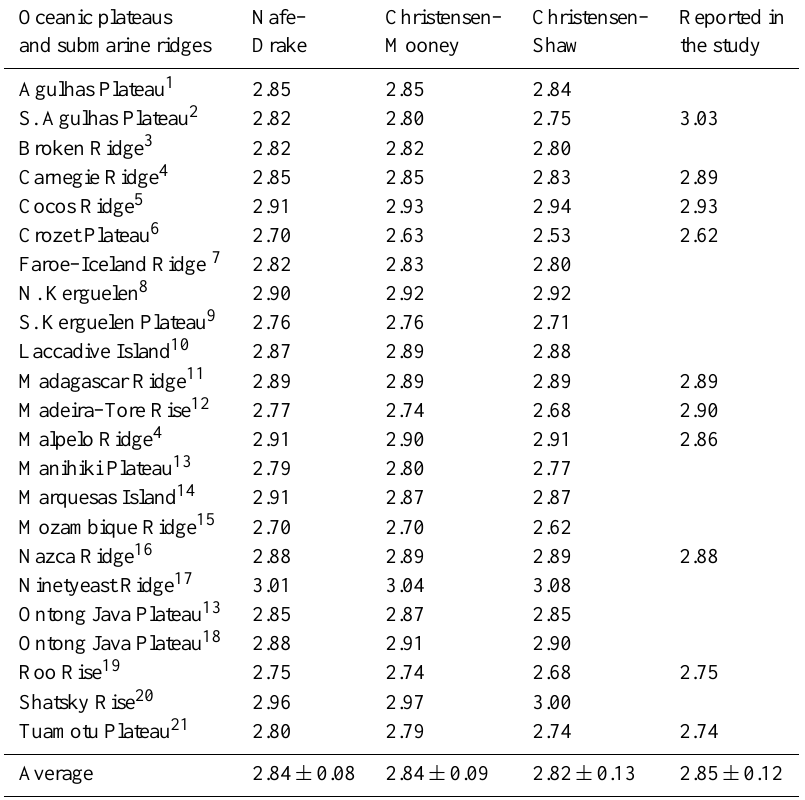
Table 4. Bulk crustal densities of oceanic plateaus and submarine ridges. Bulk crustal densities (in gcm − 3 ) are determined from seismic velocities using different seismic velocity–density relationships. Bulk densities are also reported from studies where the authors combined gravity and seismic data to determine crustal density. References are (1) Parsiegla et al. (2008), (2) Gohl and Uenzelmann-Neben (2001), (3) Francis and Raitt (1967), (4) Sallares et al. (2003), (5) Recq et al. (1998), (6) Walther (2003), (7) Bohnhoff and Makris (2004), (8) Charvis and Operto (1999), (9) Operto and Charvis (1995), (10) Gupta et al. (2010), (11) Sinha et al. (1981), (12) Peirce and Barton (1991), (13) Hussong et al. (1979), (14) Caress et al. (1995), (15) Hales and Nation (1973), (16) Hampel et al. (2004), (17) Grevemeyer et al. (2000), (18) Miura et al. (2004b), (19) Shulgin et al. (2011), (20) Den et al. (1969), and (21) Patriat et al. (2002). Oceanic plateaus Nafe– Christensen– Christensen– Reported in Drake Mooney